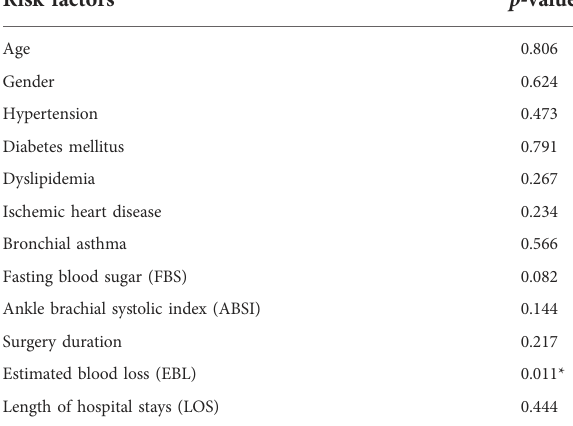
TABLE 1 Correlation between risk factors and post-surgical